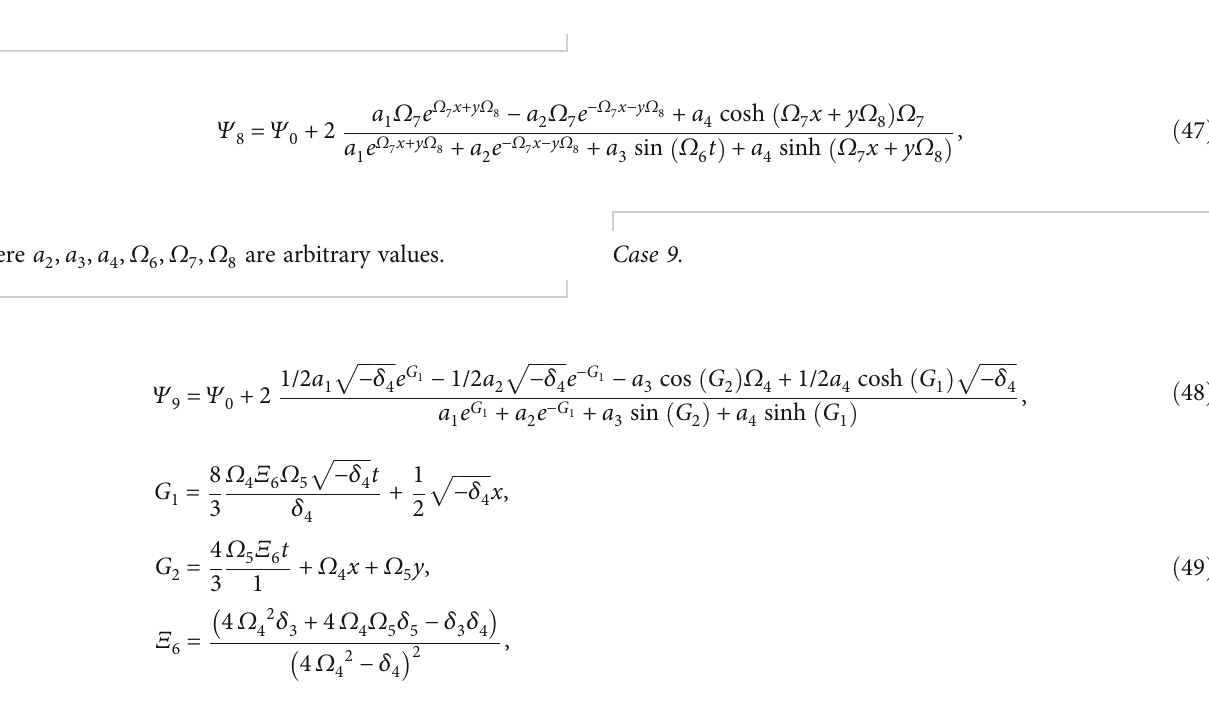
Figure 5: Plot evolution of periodic waves (23) utilizing values a = 1 : 3, δ = 2, Ψ = 1, t = 10 and (a) 3D plot, (b) density plot, and (c) contour 5 0